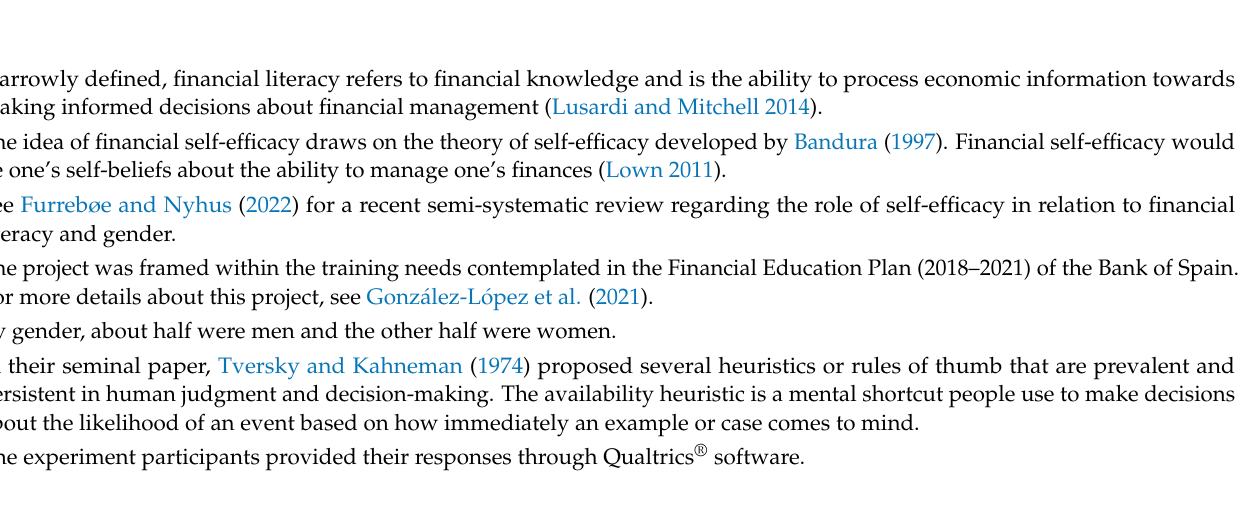
Figure A1. The average causal mediation effect (ACME): Sensitivity analysis. Source: author’s elab- oration.